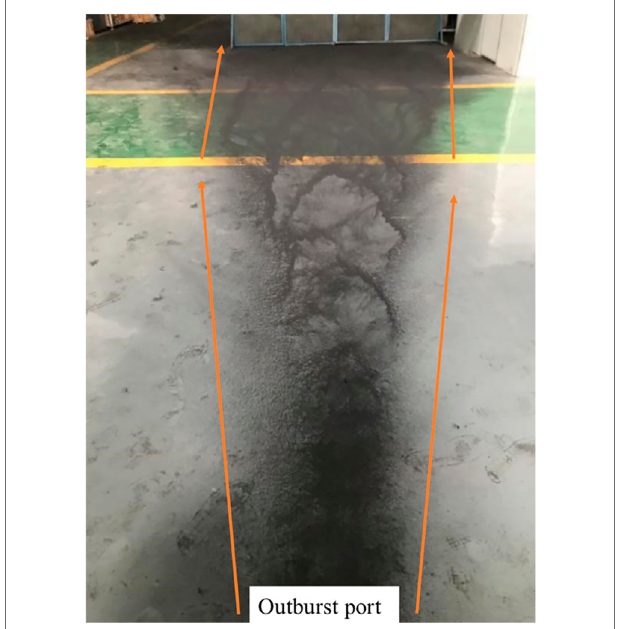
FIGURE 5 | Shape characteristics of the outburst coal powder thrown